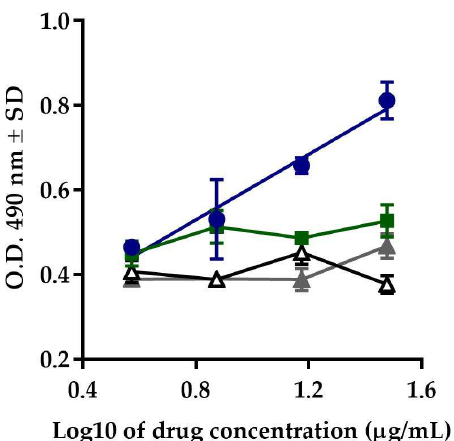
Figure 3. Specificity. Comparison of the response of Transferon ® (blue circles) with Colagenart ® (green squares), Copaxone ® (white triangles), and the vehicle control (grey triangles).